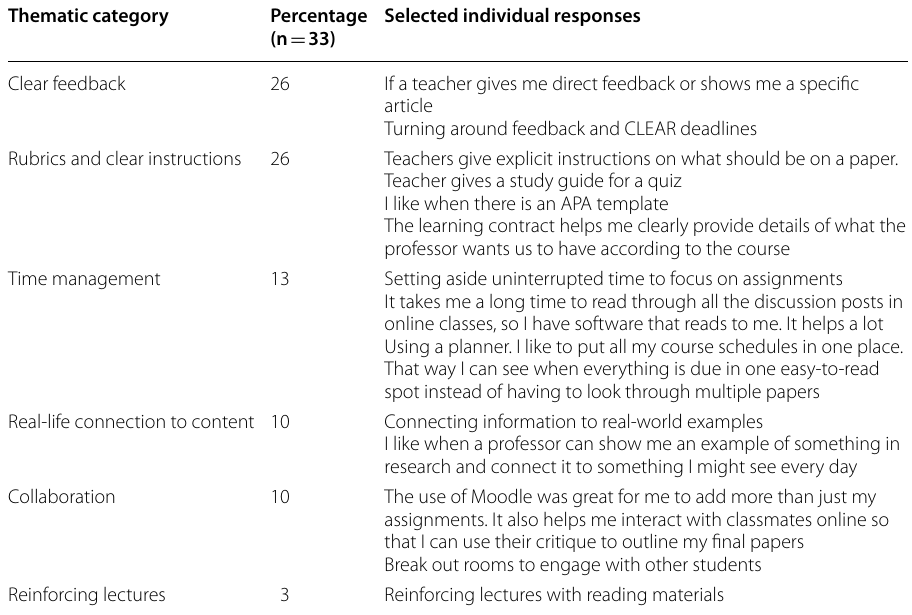
Table 8 Thematic coding of open-ended question 1 Thematic